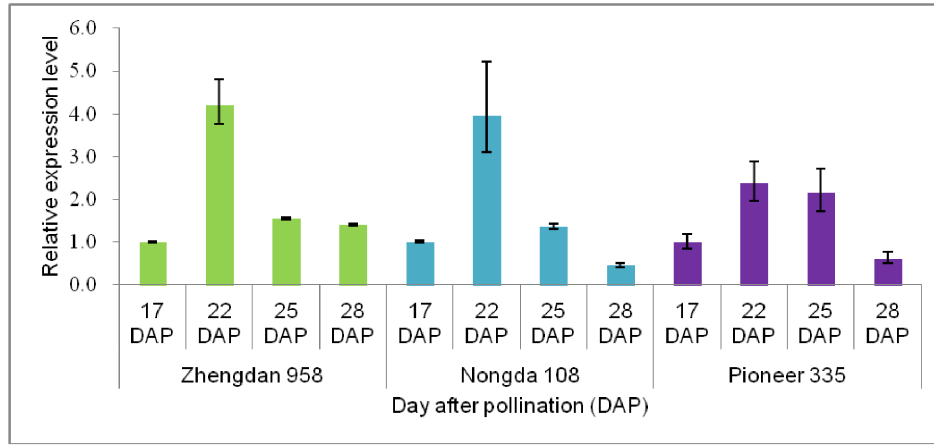
Figure 5. Relative expression level of the gene that encodes protein sdh1 ( spot no. 11).